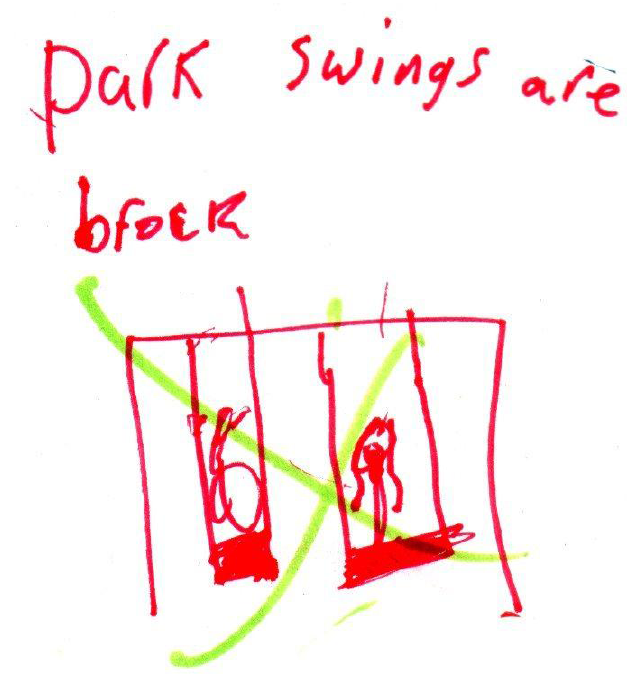
Figure 1. Child’s drawing on ‘the Wheel’ reading ‘Park swings are